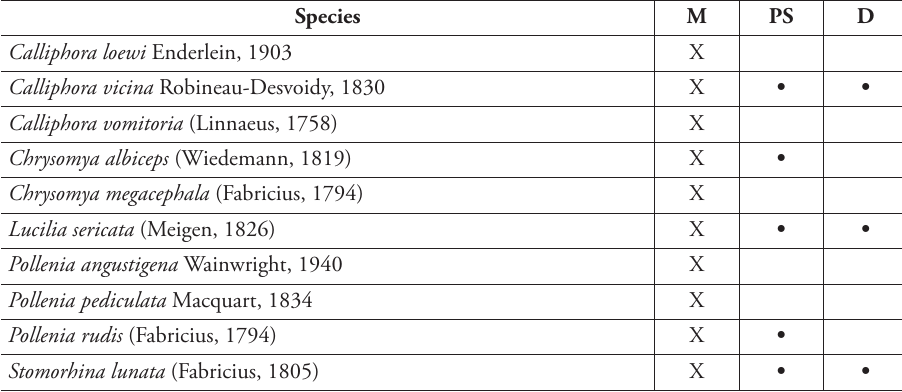
Table 2. Updated list of the Calliphoridae and Rhiniidae of the Madeira Archipelago. New records are indicated by a full black circle. M – Madeira Island, PS – Porto Santo Island and surrounding islets, D – Desertas islands (Ilhéu Chão, Deserta Grande and Bugio). Species M PS D